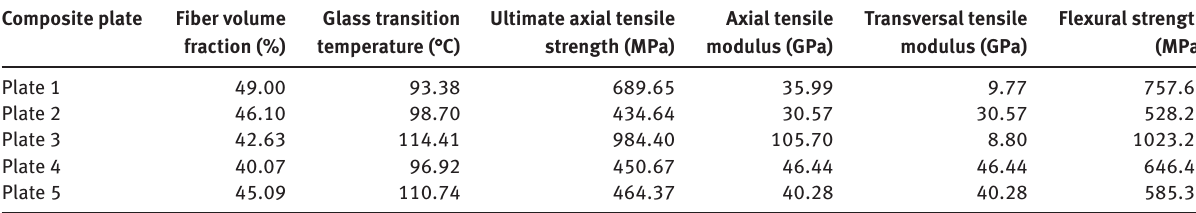
Table 3: Material characterization results.